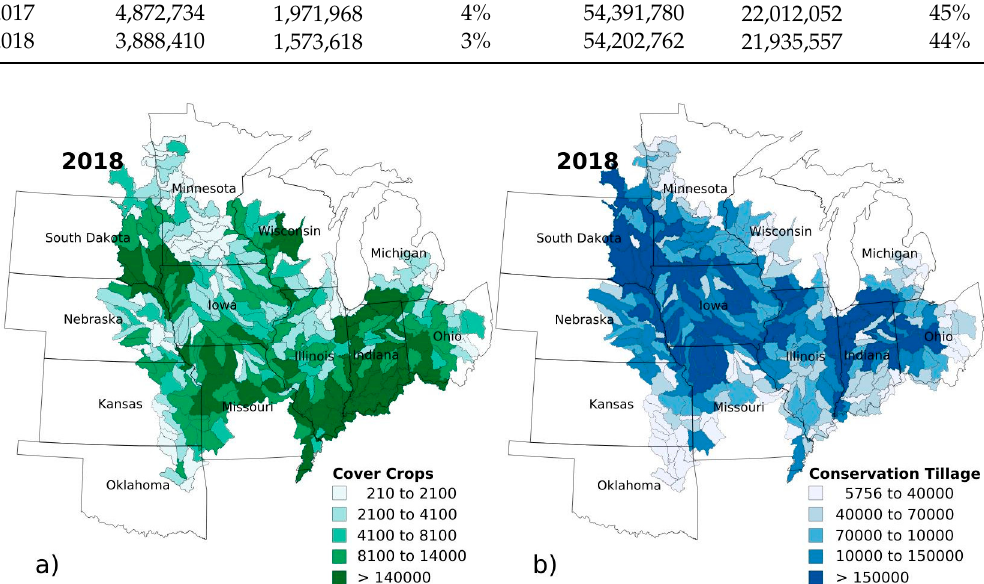
Figure 7. ( a ) Cover crop hectares and ( b ) conservation tillage hectares across HUC 8 watersheds 2018. for Table 5. Yearly cover crops planted after soy and corn and conservation tillage acres in the Corn Belt. % Area Cover Cover of Cover Years Crop Acres Crop Ha Crops